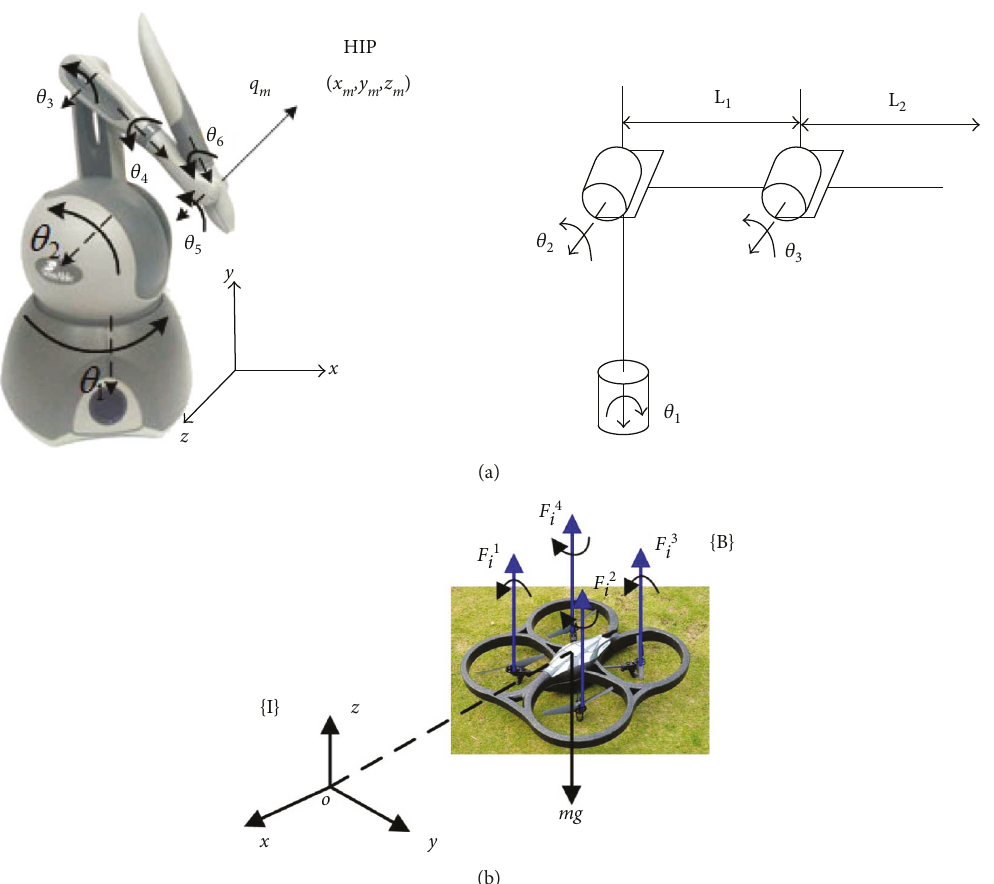
Figure 2: The devices in the bilateral teleoperation system. (a) The physical map and kinematic model diagram of the master device. (b) The slave